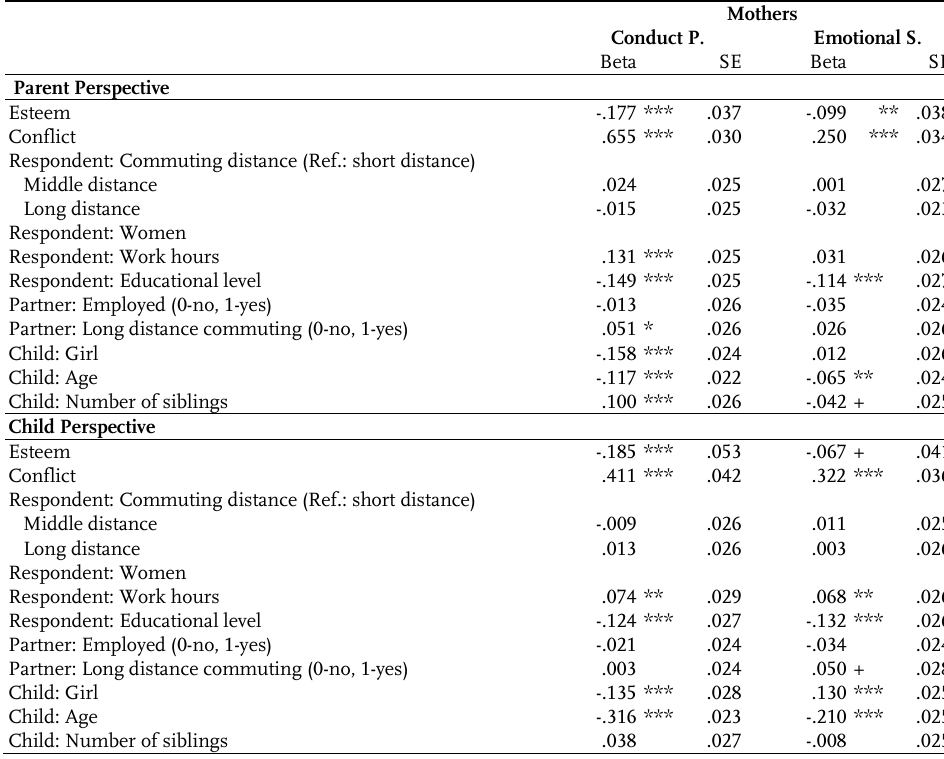
Table 5 : The association between the parent-child relationship (measured by esteem and conflict) and the child’s well-being (measured by conduct problems and emotional symptoms) (continued)